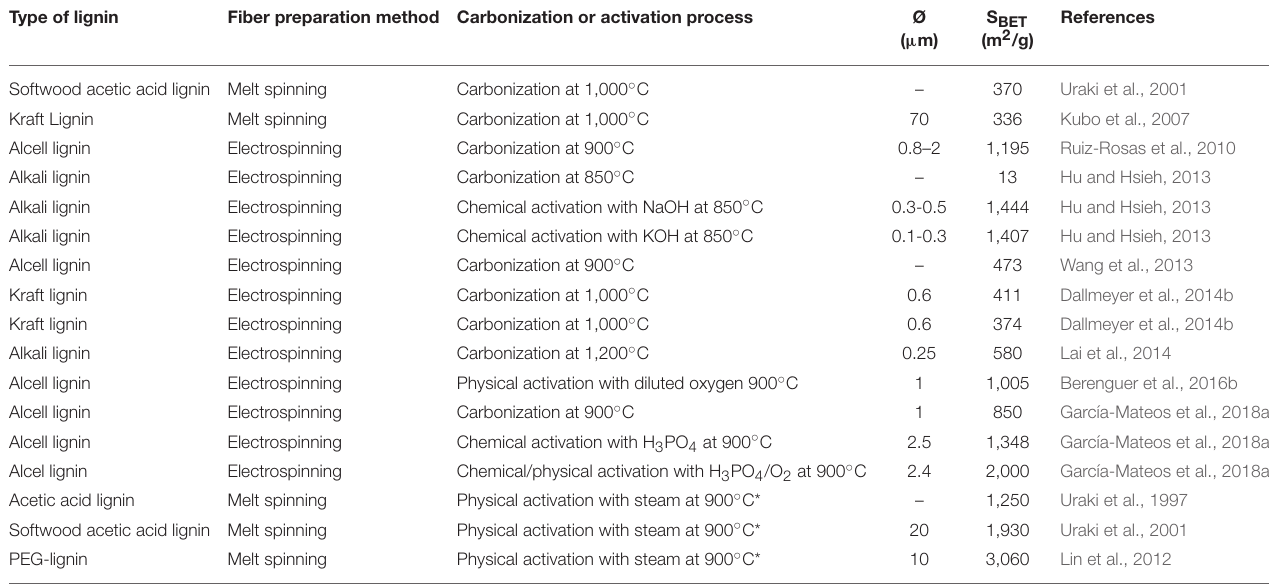
TABLE 1 | Specific surface areas of carbon fibers prepared from different types of